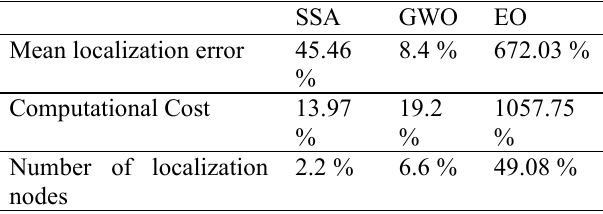
Table 5. Percentage improvement of the HHO algorithm over other